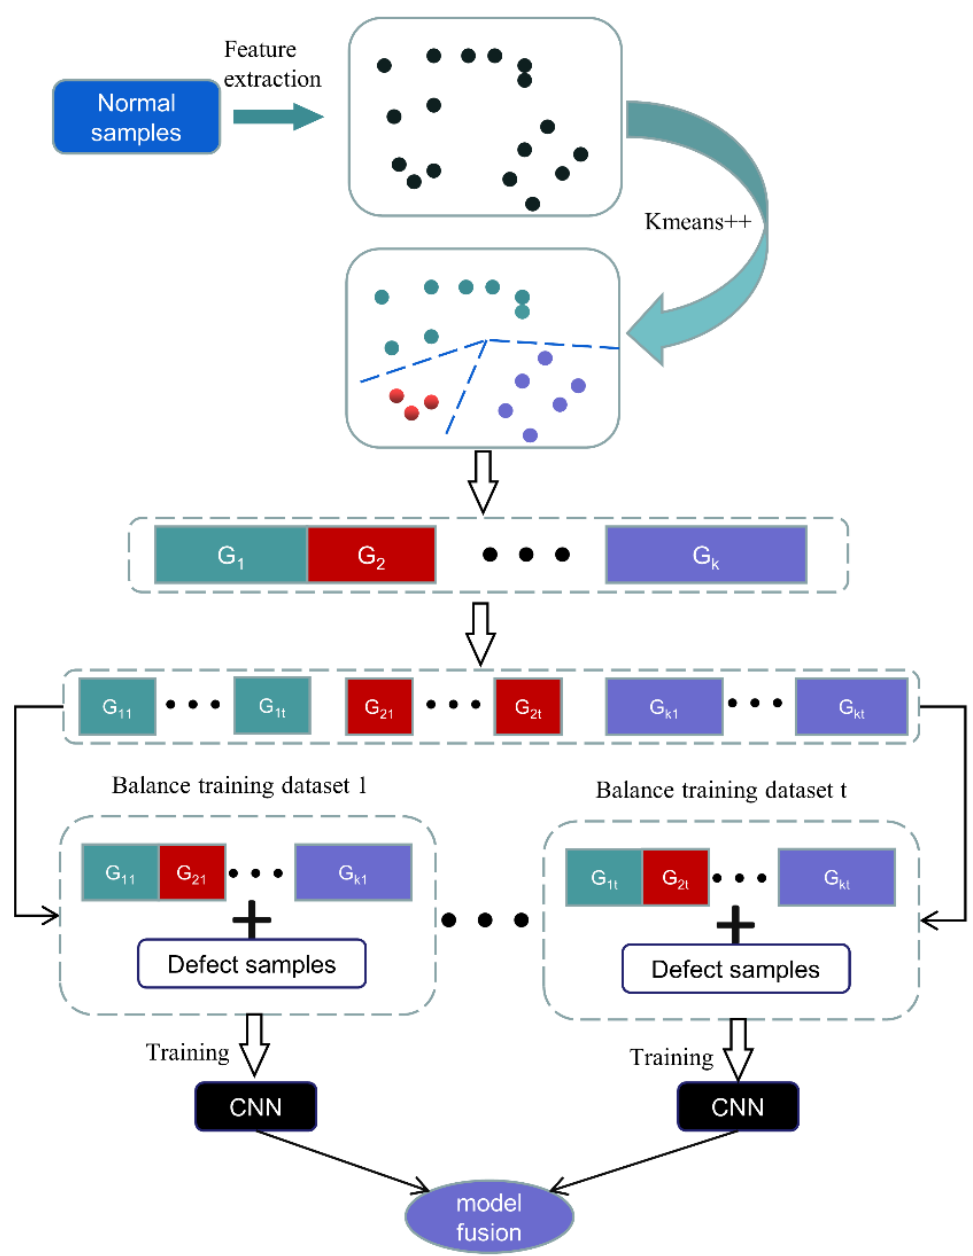
Figure 2. The pipeline of the proposed method.